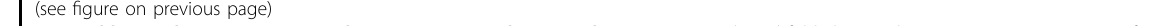
Fig. 3 Shh signaling imparts Imatinib resistance via Bcl2 upregulation. A RT-PCR-based fold change determination in expression of various genes known for their role in drug resistance. Imatinib-treated Shh-K562 cells (TShh-K562) and treated K562 (TK562) normalized to their respective untreated controls, at 72 h. Bars represents mean ± SD from three biological repeats. B mRNA-fold change of three anti-apoptotic genes, Bcl2 , Mcl-1 , Bcl-xL , measured using RT-PCR in Imatinib-treated Shh-K562 (TShh-K562) normalized to Imatinib-treated K562 (TK562). Bars represents mean ± SD from two biological repeats. C Western blot representing expression of Bcl2 and Mcl-1 from untreated and Imatinib-treated cells (K562, Shh-K562, TK562, and TShh-K562). GAPDH is used as loading control. The graph represents densitometric analysis of relative protein levels normalized to untreated K562. Bar represents mean ± SD from three biological repeats. D Time-curve representing viability (MTT assay) of K562 (black dotted line) and Shh-K562 (green dotted line) cell lines after treatment with Imatinib (0.5 µM); K562 (black solid line) and Shh-K562 (green solid line) for Imatinib (0.5µM) + Cyclopamine (25 nM) treated conditions; gray solid line represents viability of K562 after Cyclopamine treatment (25 nM). Graph represents mean ± SD from three biological repeats. E RT-PCR data determining the level of Bcl2-mRNA in K562 and Shh-K562 after treatment for 72 h with either vehicle control (untreated), Imatinib-alone, or Imatinib + Cyclopamine normalized to their respective K562 controls (black dotted line at 1). Bar represents mean ± SD from two biological repeats. For all assays, P values, *<0.05, **<0.01, and ***<0.001. Statistical analysis done using t